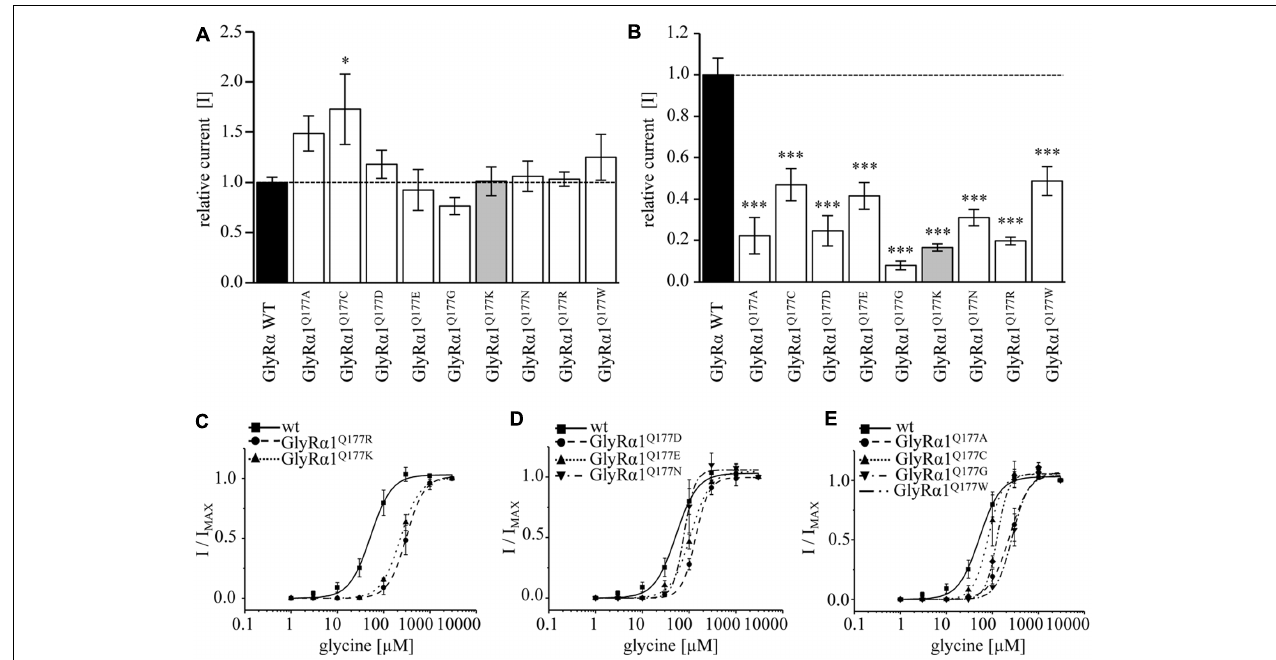
FIGURE 4 | β 8– β 9 GlyR α 1 Q177 variants lead to changes in ion channel characteristics. All electrophysiological recordings were performed from transfected HEK293 cells expressing αβ heteromeric receptors with GlyR α 1 mutants or WT and GlyR β WT. Functional parameters from whole-cell recordings of transfected HEK293 cells with GlyR α 1 β WT or GlyR α 1 Q177 β variants, mean values of current amplitudes at 1 mM (A) and 100 µ M (B) of glycine ( n = 5–8 cells) are shown. The mean of GlyR α 1 β WT was set to 1 (marked by dotted line). Level of significance ∗ p < 0.05, ∗∗∗ p < 0.001. (C–E) Ligand binding potencies (EC 50 ) determined by whole-cell current measurements of transfected cells expressing GlyR α 1 β WT or GlyR α 1 Q177 β variants with eight different glycine concentrations (1–3000 µ M, n = 3–5 for each receptor